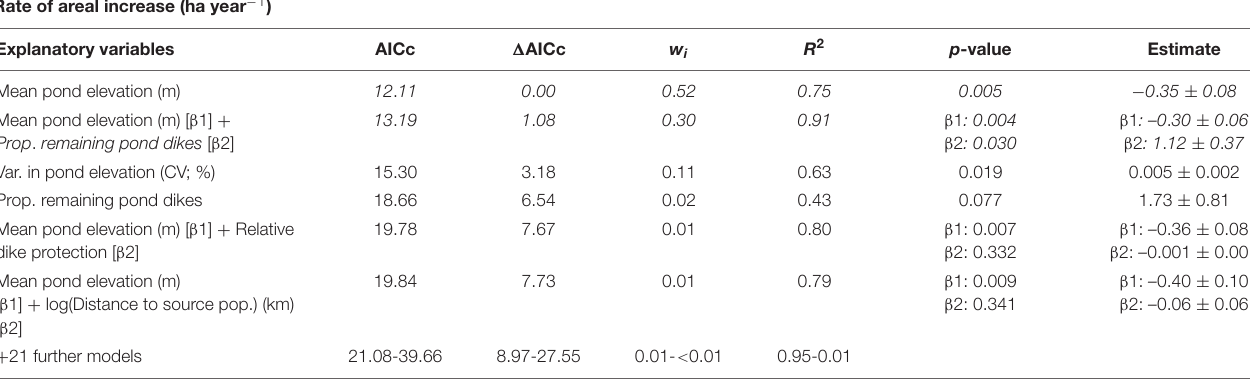
TABLE 3 | Top six best-fitting candidate linear models for “rate of areal increase.” Rate of areal increase (ha year − 1 )